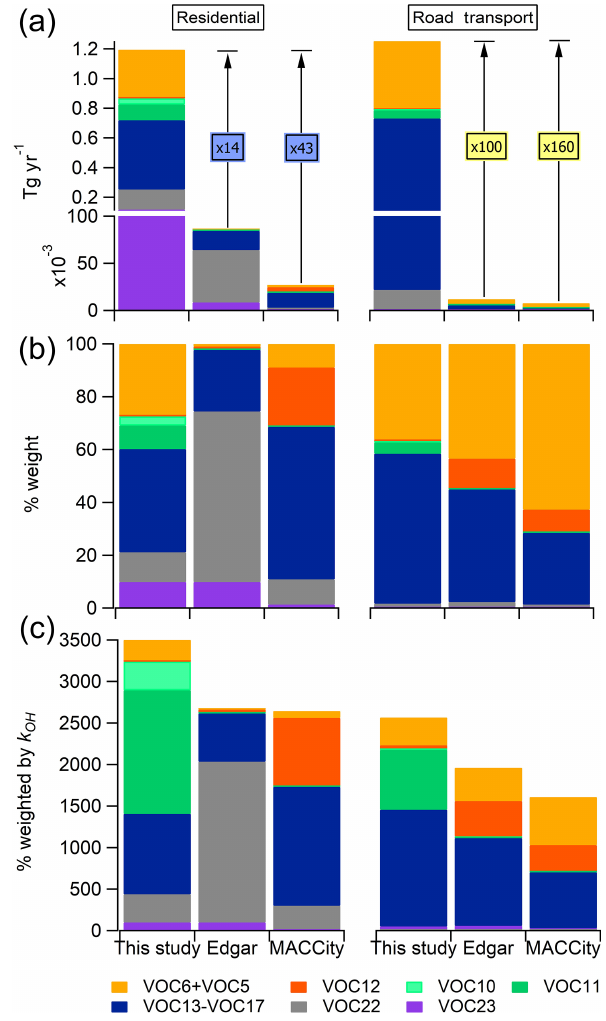
Figure 8. Comparison of VOC emission profiles for Côte d’Ivoire from the emissions estimated from the measurements of this study and the EDGAR v4.3.2 (Huang et al., 2017) and MACCity inven- tories (Granier et al., 2011). The profile analysis integrates road transportation and residential sectors based on the sector activity for 2012. (a) Absolute emissions, in Tgyr − 1 , (b) relative mass contri- bution, and (c) relative mass reactivity, considering 100Tg of emis- sions weighted by the k OH reaction rate calculated for each VOC